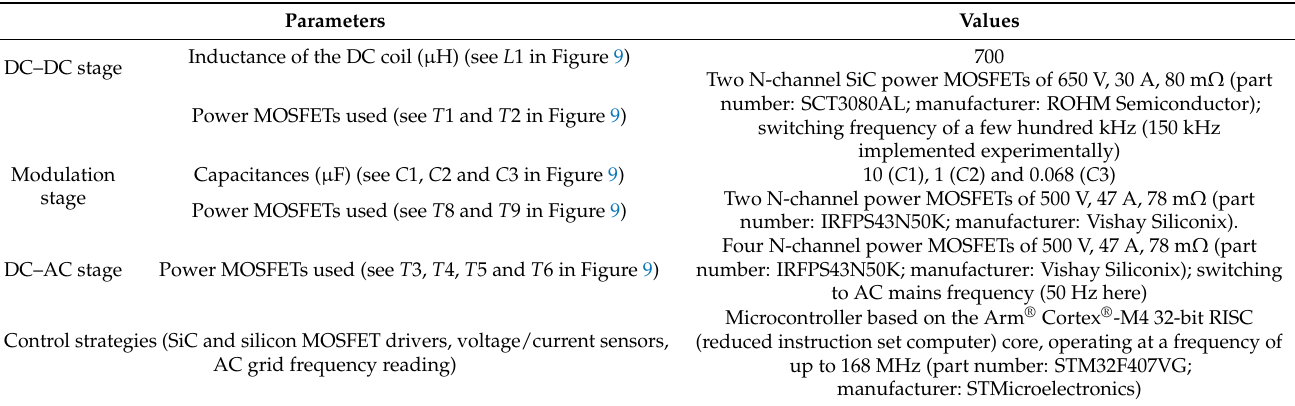
Table 2. A selection of the main